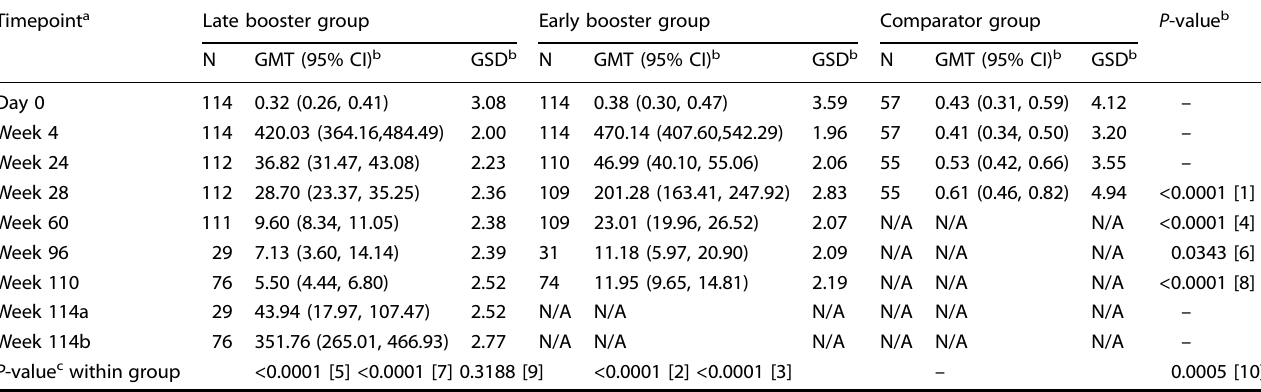
Table 2. Geometric mean titers (GMTs) of Anti-Vi IgG ELISA response — immunogenicity set. Timepoint